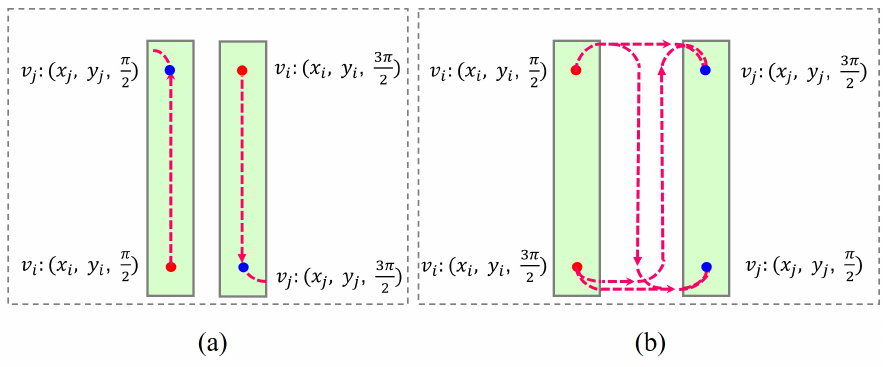
Figure 4. The start pose v i : ( x i , y i , θ i ) and target pose v j : ( x j , y j , θ j ) . ( a ) v i and v j belong to different cells. ( b ) v i and v j belong to the same